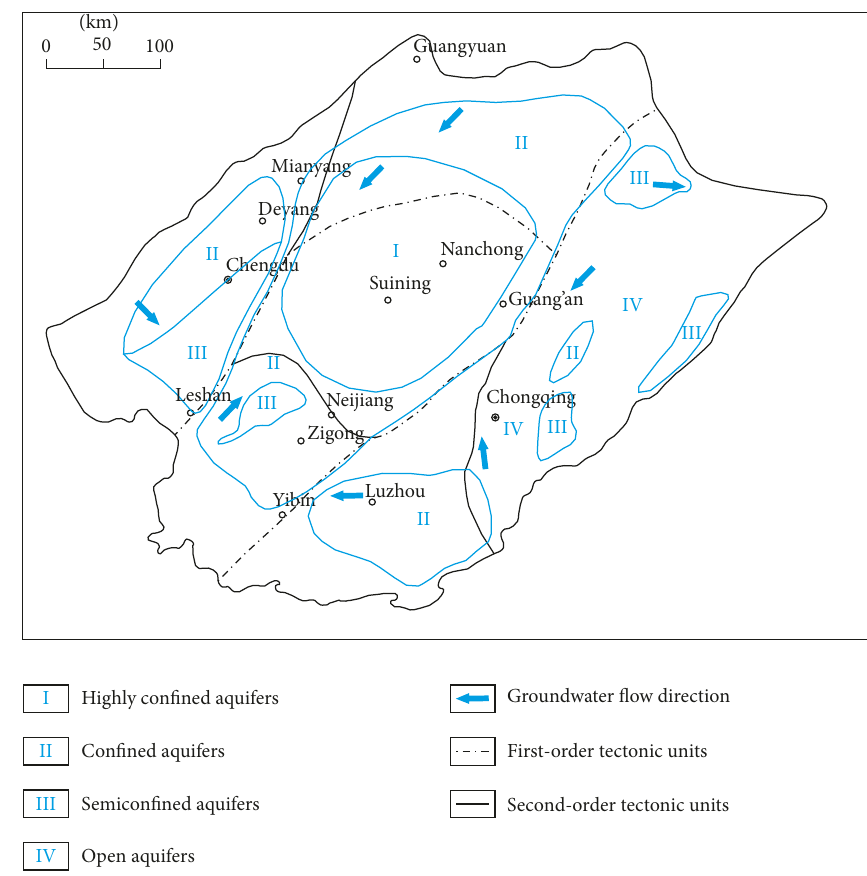
Figure 3: Hydrodynamic conditions in the Sichuan Basin. The groundwater activities are very strong in the peripheral target exposure area. In contrast, the groundwater activities inside the basin are relatively weak, with better hydrogeological confinement. On the edge of the mountain around the Sichuan Basin and the eastern fold belt experiencing infiltration of fresh water due to the complex structure and strong water